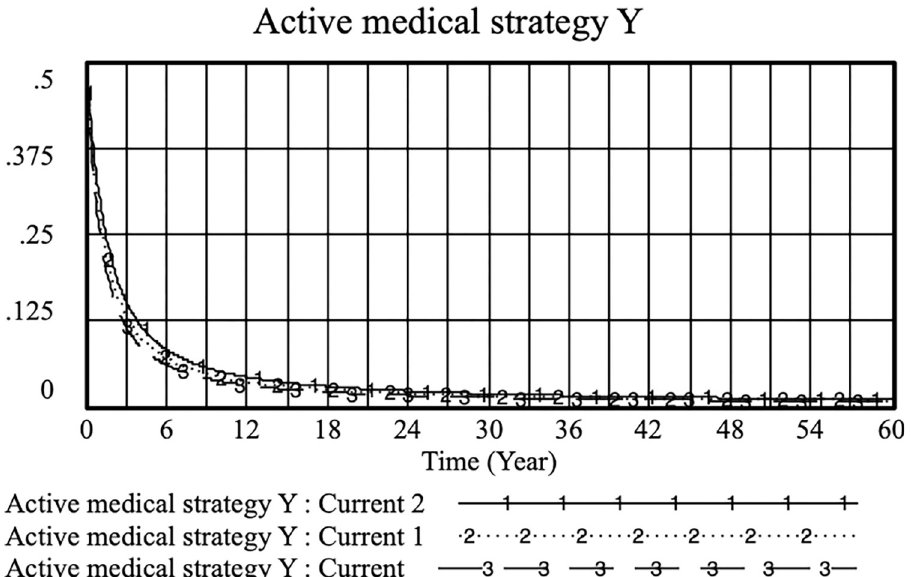
Fig 2. Effect of PE 1 on the physician positive strategy selection. (current: PE 1 = 0.4; current 1; PE 1 = 0.6 and current 2:PE 1 = 0.8).